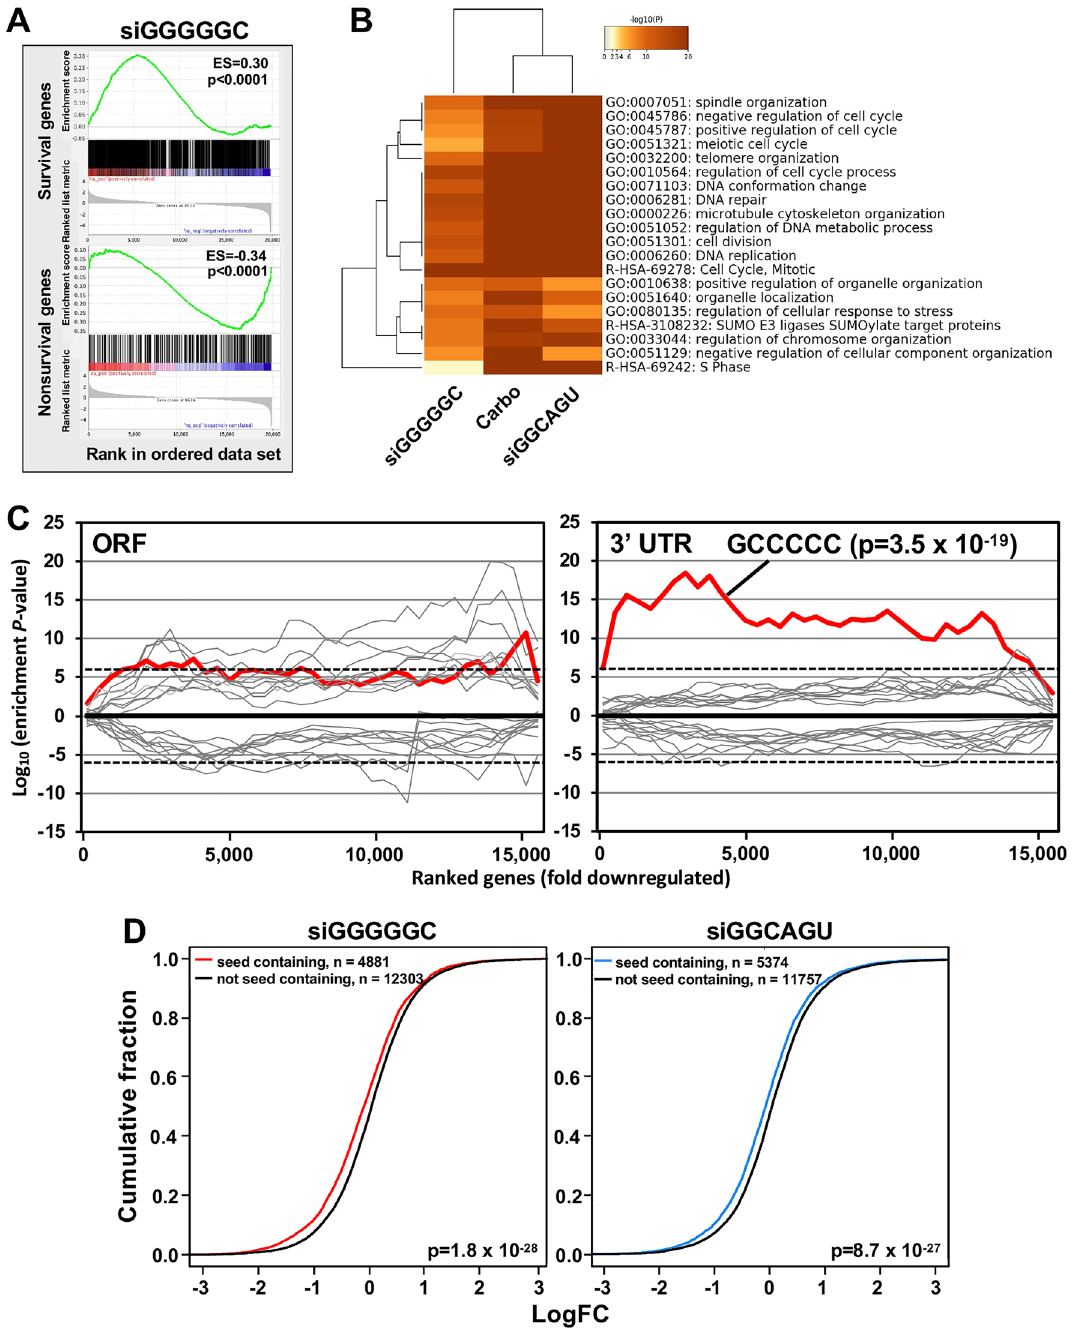
Figure 3. siGGG GGC is toxic to cancer cells through DISE induction. ( A ) Gene set enrichment analysis for a group of 1846 survival genes (top panel) and 416 non-survival genes (bottom panel) 10 48 h after transfecting HeyA8 cells with siGGG GGC . siNT1 served as a control. p-values indicate significance of enrichment; the enrichment score (ES) is shown. ( B ) Metascape gene ontology analysis comparing genes significantly downregulated from the RNA-seq data in HeyA8 cells treated with siGGG GGC , carboplatin or siGGC AGU for 48 h. ( C ) Sylamer analysis (6mers) for the list of open reading frames (ORFs; left) and 3 ′ UTRs (right) of mRNAs in cells treated with 10 nM siGGG GGC for 24 h sorted from down-regulated to up-regulated. The 10 most and ten least enriched seeds are shown. Enrichment of the GCC CCC sequence is shown in red, other sequences are in grey. The stippled line corresponds to a p-value threshold of 0.05 after Bonferroni correction for the number of words tested (4096). Bonferroni-adjusted p-value is shown. ( D ) eCDF plots of mRNAs (in RNA isolated from PC3 cells 24 and 48 h after transfection) containing a unique 6mer seed match for either siGGC AGU (left) or siGGG GGC (right) in their 3 ′ UTR vs those that do not. The p-values were calculated using a two-sample Kolmogorov–Smirnov (K–S) test (alternative hypothesis =